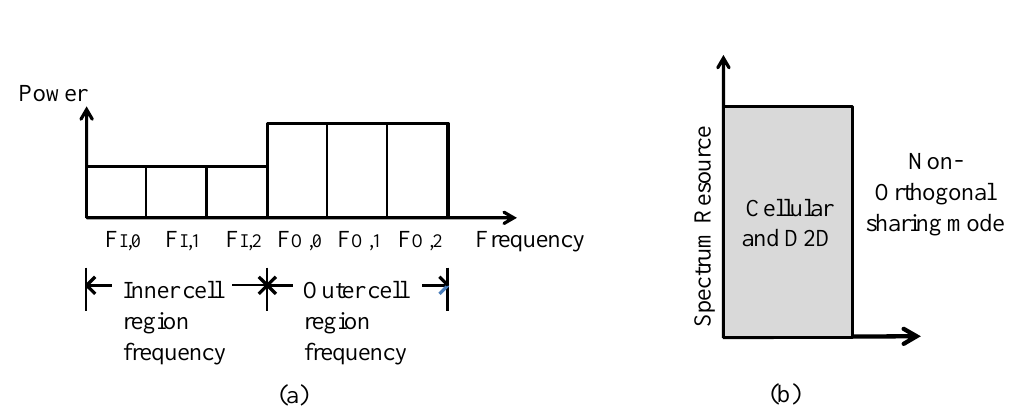
Figure 2. ( a ) Spectrum partitioning and ( b ) non-orthogonal spectrum resource sharing.